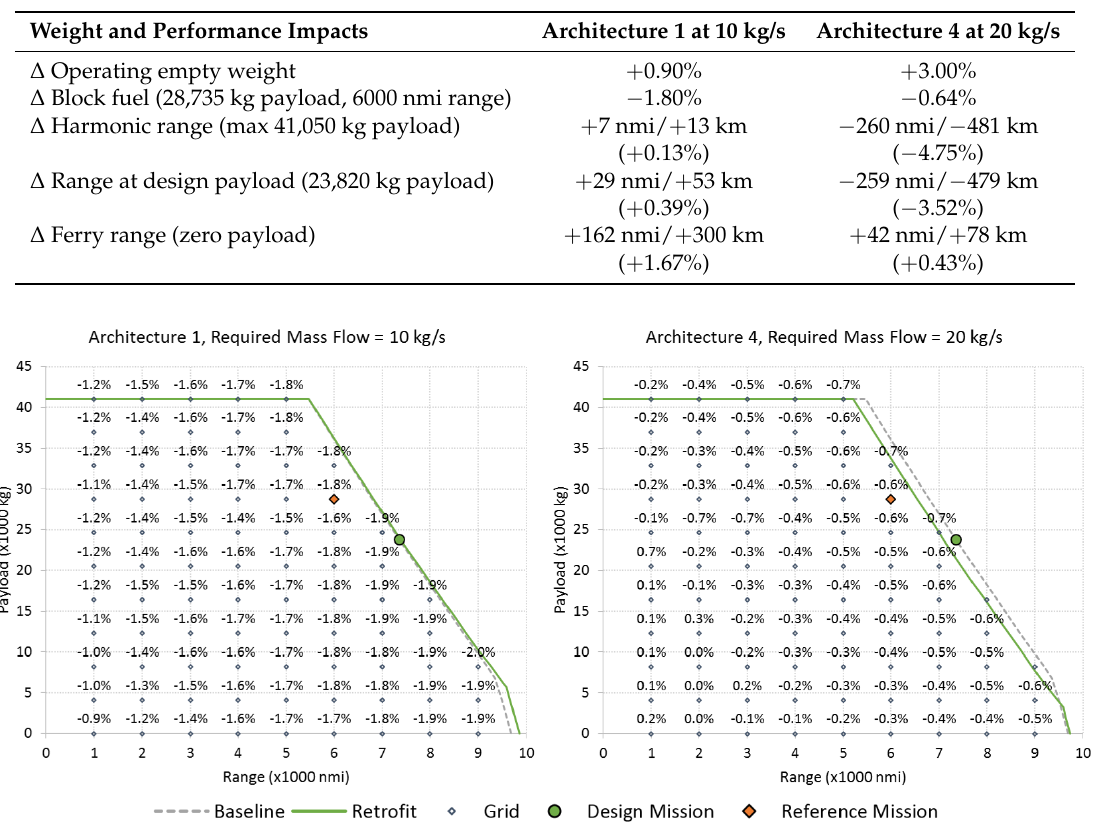
Figure 7. Payload-range characteristics and change in block fuel of two HLAFC architectures at different mass flow